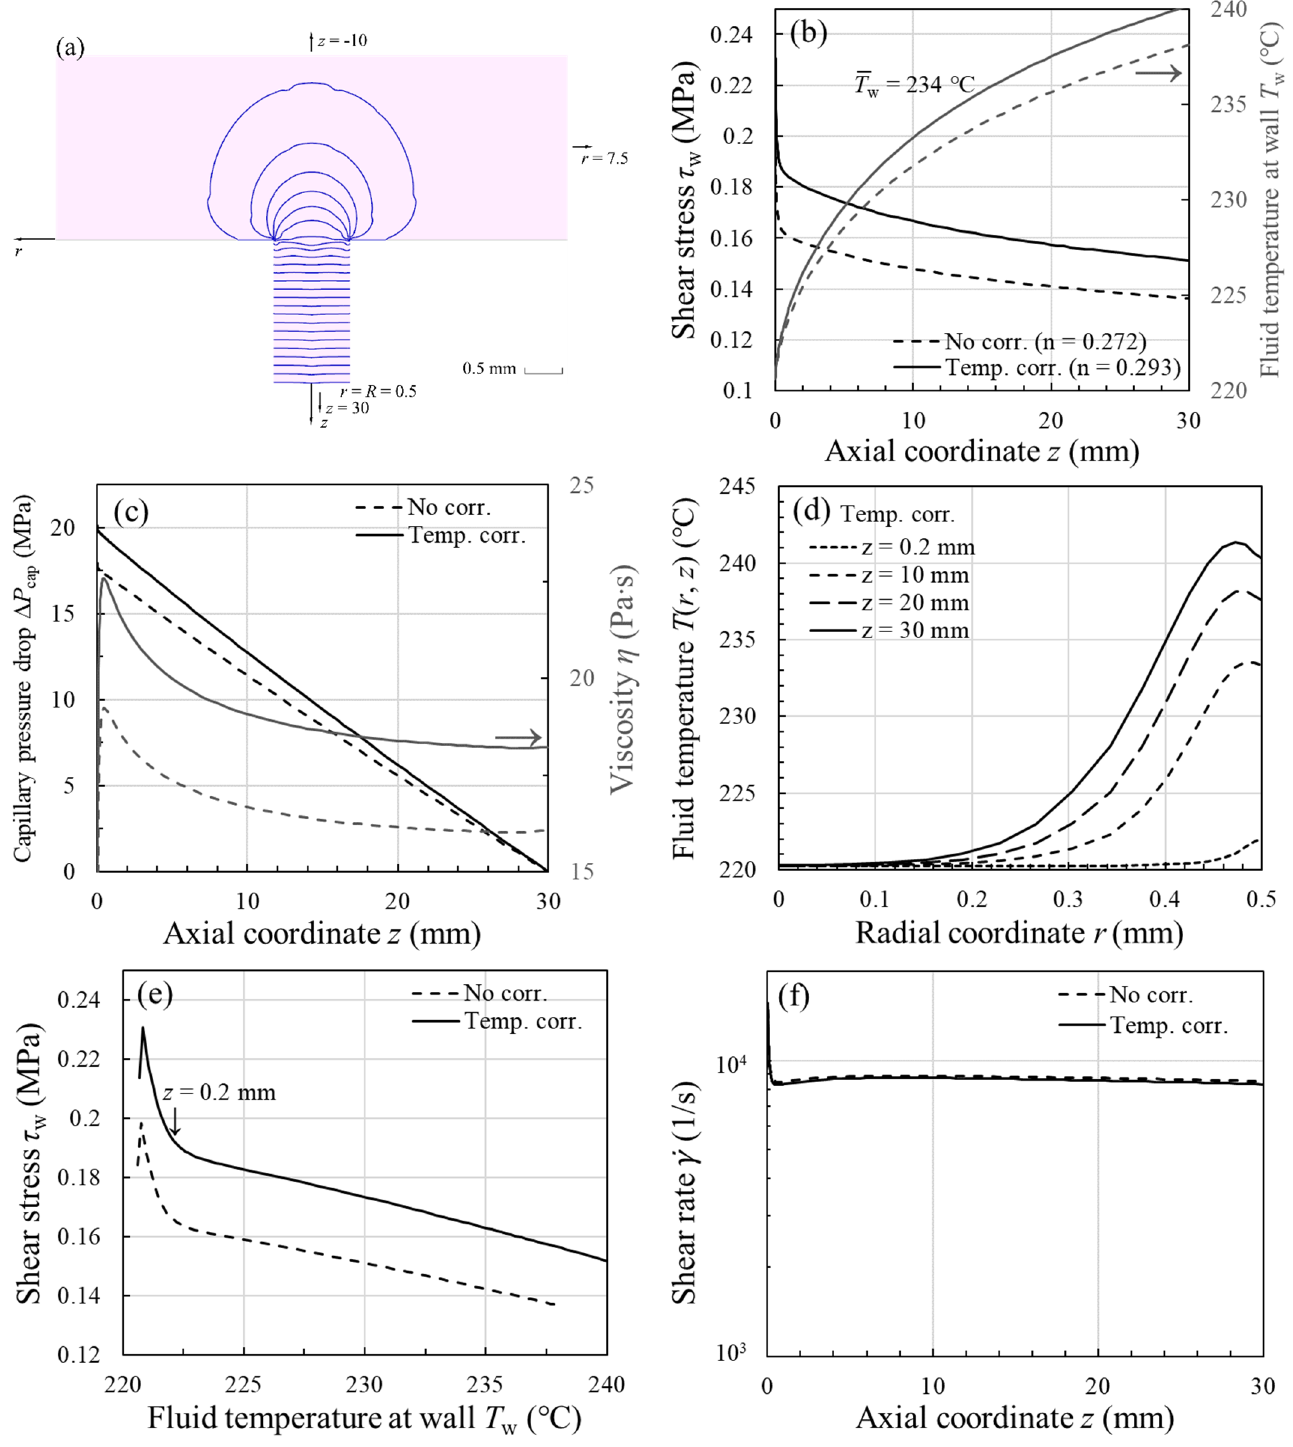
Figure 5. Graphs elucidating the simulated rheological properties along the capillary wall for HIPS at γ a = 5000 s − 1 and T 0 = 220 ◦ C, based on η ( γ ) with and without temperature correction: ( a ) Pressure iso-contours in the contraction region and axial variations of ( b ) shear stress τ w and fluid temperature T w , ( c ) capillary pressure drop ∆ P cap and polymer viscosity η , ( d ) fluid temperature profile T ( r , z ) , and ( f ) shear rate γ . The data of ( b ) are replotted against T w in ( e ) to reveal an approximately linear relationship between τ w and T w When (cid:2028) (cid:2933) is plotted versus (cid:1846) (cid:2933) in Figure 5e, we see a nearly linear relation between the two quantities, especially when the entrance length has been exceeded (i.e., (cid:1878) > 0.2 mm). Thus, it explains why, in going from Equation (11) to (12), we have used the mean